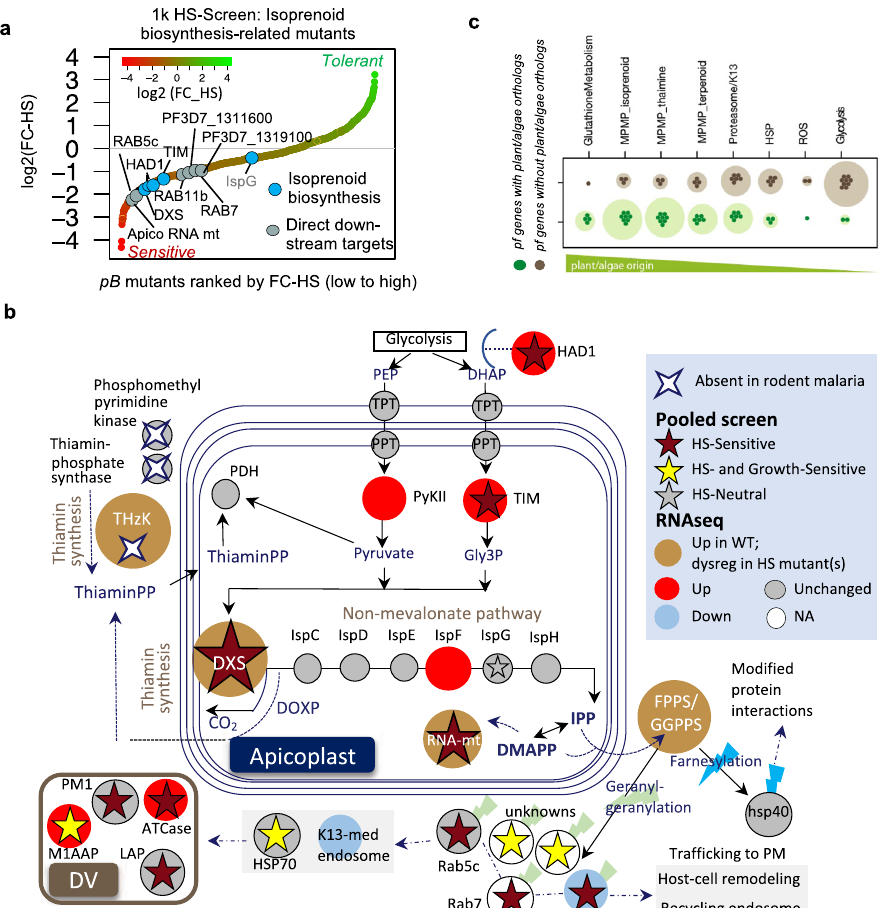
Fig. 5 Apicoplast isoprenoid biosynthesis is critical for P. falciparum survival of febrile temperatures. a Ten of 11 pB- mutants in genes related to apicoplast isoprenoid biosynthesis represented in the 1K-library were HS-Sensitive. Mutants are ranked by phenotype from HS-Sensitive (red) to HS- Tolerant (green). Circles indicate each HS-Sensitive mutant related to isoprenoid biosynthesis. *The isoprenoid biosynthesis genes we identi fi ed as directly upregulated in response to HS via RNAseq (DXS, PF3D7_1337200; apicoplast RNA methyltransferase, PF3D7_0218300). b Key enzymes in the P. falciparum isoprenoid biosynthesis pathway are upregulated in response to heat-shock (red circle), dysregulated in HS-Sensitive mutants (ocher), and absent in malaria-parasites of hosts that do not present fever. Pathway diagram modeled from 57 . Isoprenoid biosynthesis genes upregulated in HS include DXS, 2-C-methyl- D -erythritol 2,4-cyclodiphosphate synthase (IspF, PF3D7_0209300), pyruvate kinase II (PyKII, PF3D7_1037100), phosphoenolpyruvate/ phosphate translocator (PPT, PF3D7_0530200), triosephosphate isomerase (TIM, PF3D7_1439900), triosephosphate transporter (TPT, PF3D7_1218400), and upstream-regulator of MEP-pathway substrates HAD1-phosphotase (HAD1, PF3D7_1033400) 58 . All direct downstream-targets prenylated by bifunctional farnesyl/geranylgeranyl diphosphate synthase (FPPS/GGPPS, PF3D7_1128400) with products of the MEP-pathway (zigzag) represented in pooled screening were HS-Sensitive, including the Rab-family vesicular traf fi cking proteins (Rab5c, PF3D7_0106800; Rab7, PF3D7_0903200; Rab11b, PF3D7_1340700), as were several digestive vacuole proteases and proteins involved in hemoglobin digestion (PM1, PF3D7_1407900; ATCase, PF3D7_1344800; M1AAP, PF3D7_1311800; LAP, PF3D7_1446200; HSP70, PF3D7_0818900). The key thiamin-synthesis enzyme hydroxyethylthiazole kinase (ThzK, PF3D7_1239600) is absent in P. berghei and P. yoelii , malaria-parasites whose rodent hosts do not present fever. c P. falciparum genes with plant orthologs (green circles) indicating potential endosymbiont-ancestry tend to be increased in response to HS vs. genes that do not have plant orthologs (gray circles). P. falciparum genes with potential endosymbiont-ancestry were derived from 1919 ortholog-pairs between Arabidopsis thaliana and P. falciparum (data from OrthoMCLv5.0). The listed processes are sorted based on the ratio of plant-like to non-plant-like orthologs. Source data are provided as a Source Data fi